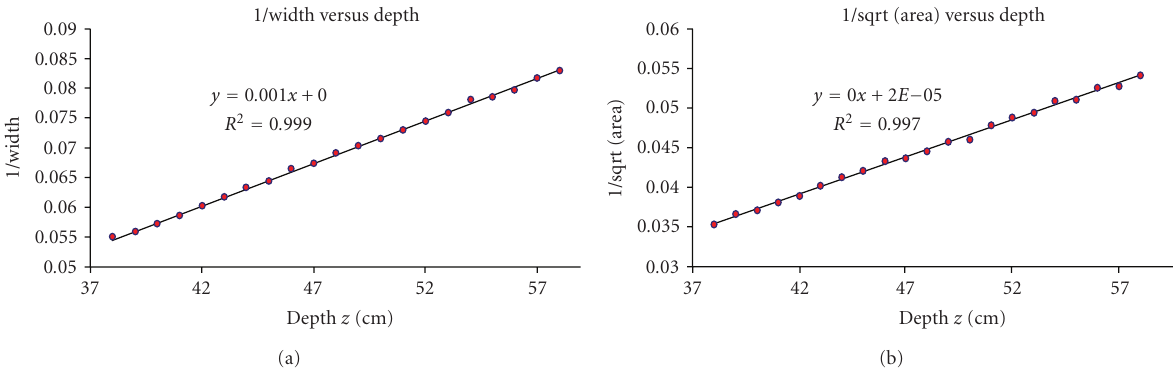
Figure 7: 8-French catheter results. (a) The inverse of the projection electrode-tip width versus depth and (b) the inverse of the projection area versus depth using a single-view